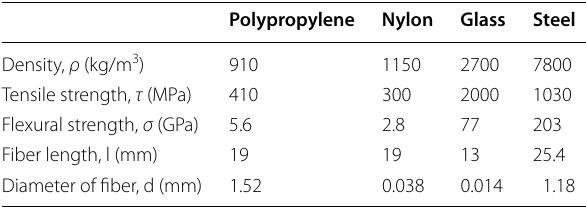
Table 2 Physical properties of four different types of fiber.